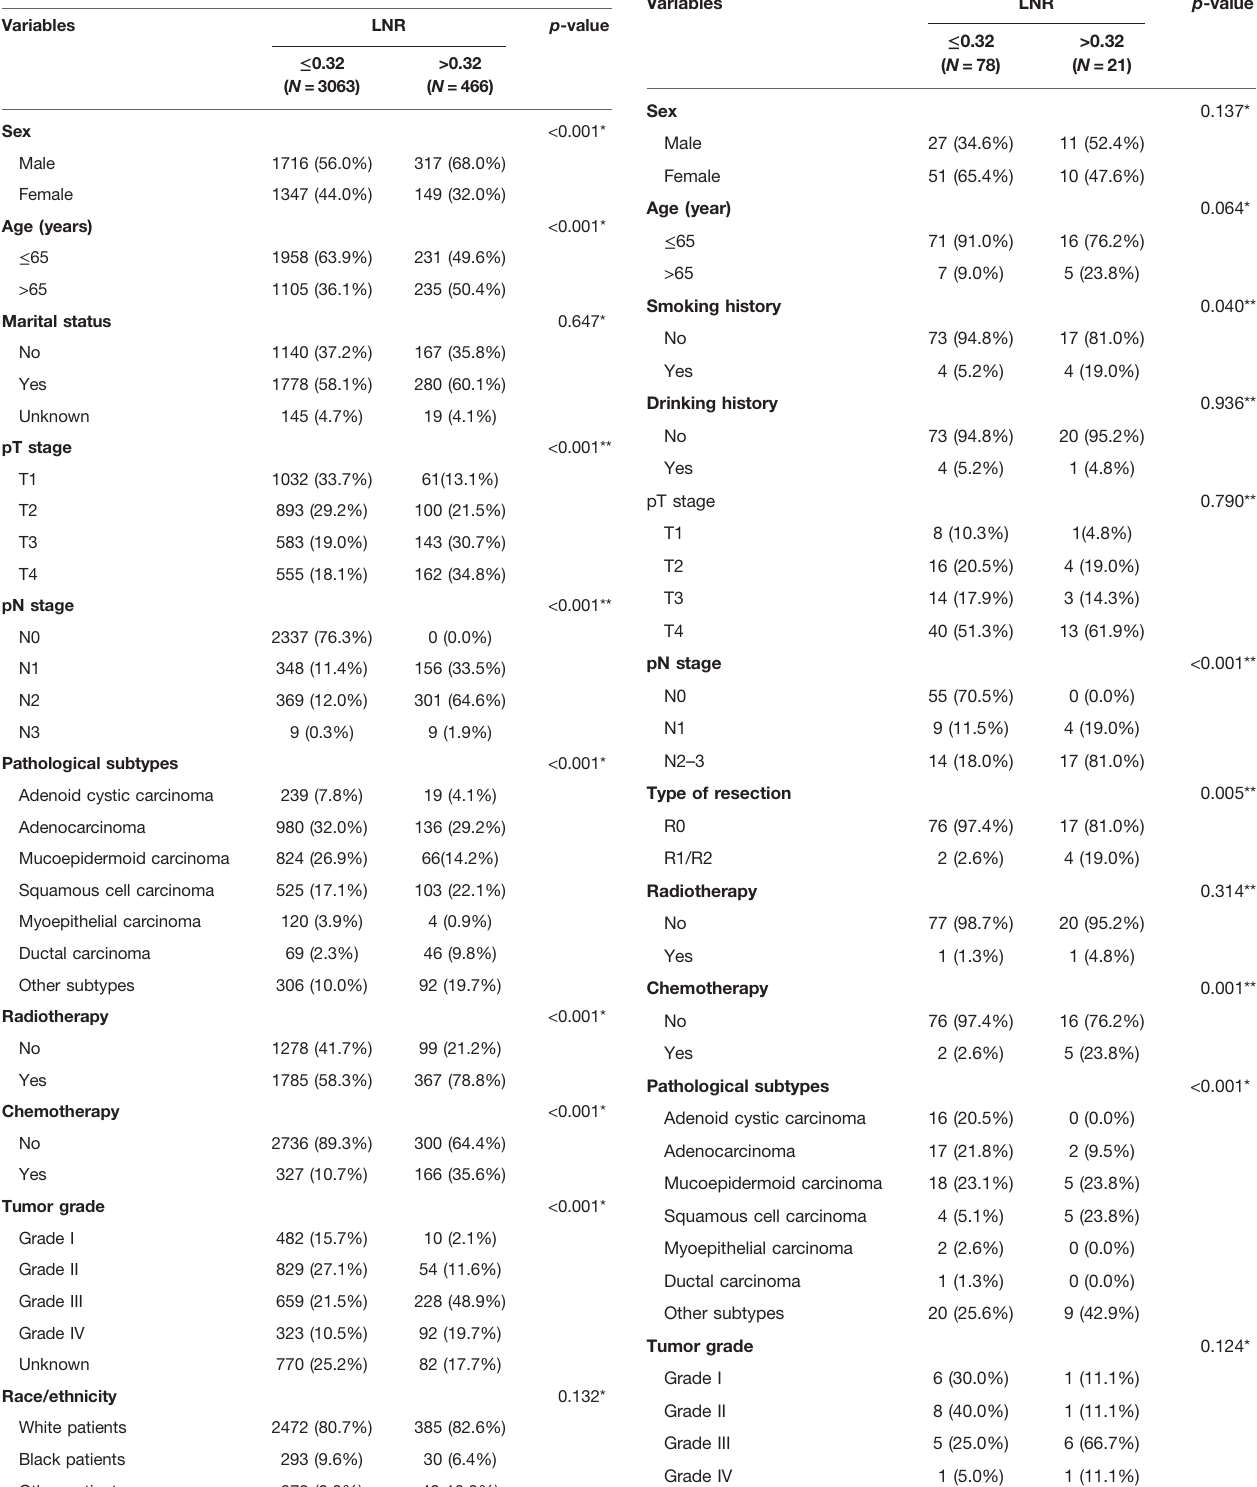
TABLE 1 | Patient characteristics in Surveillance Epidemiology and End Results database.